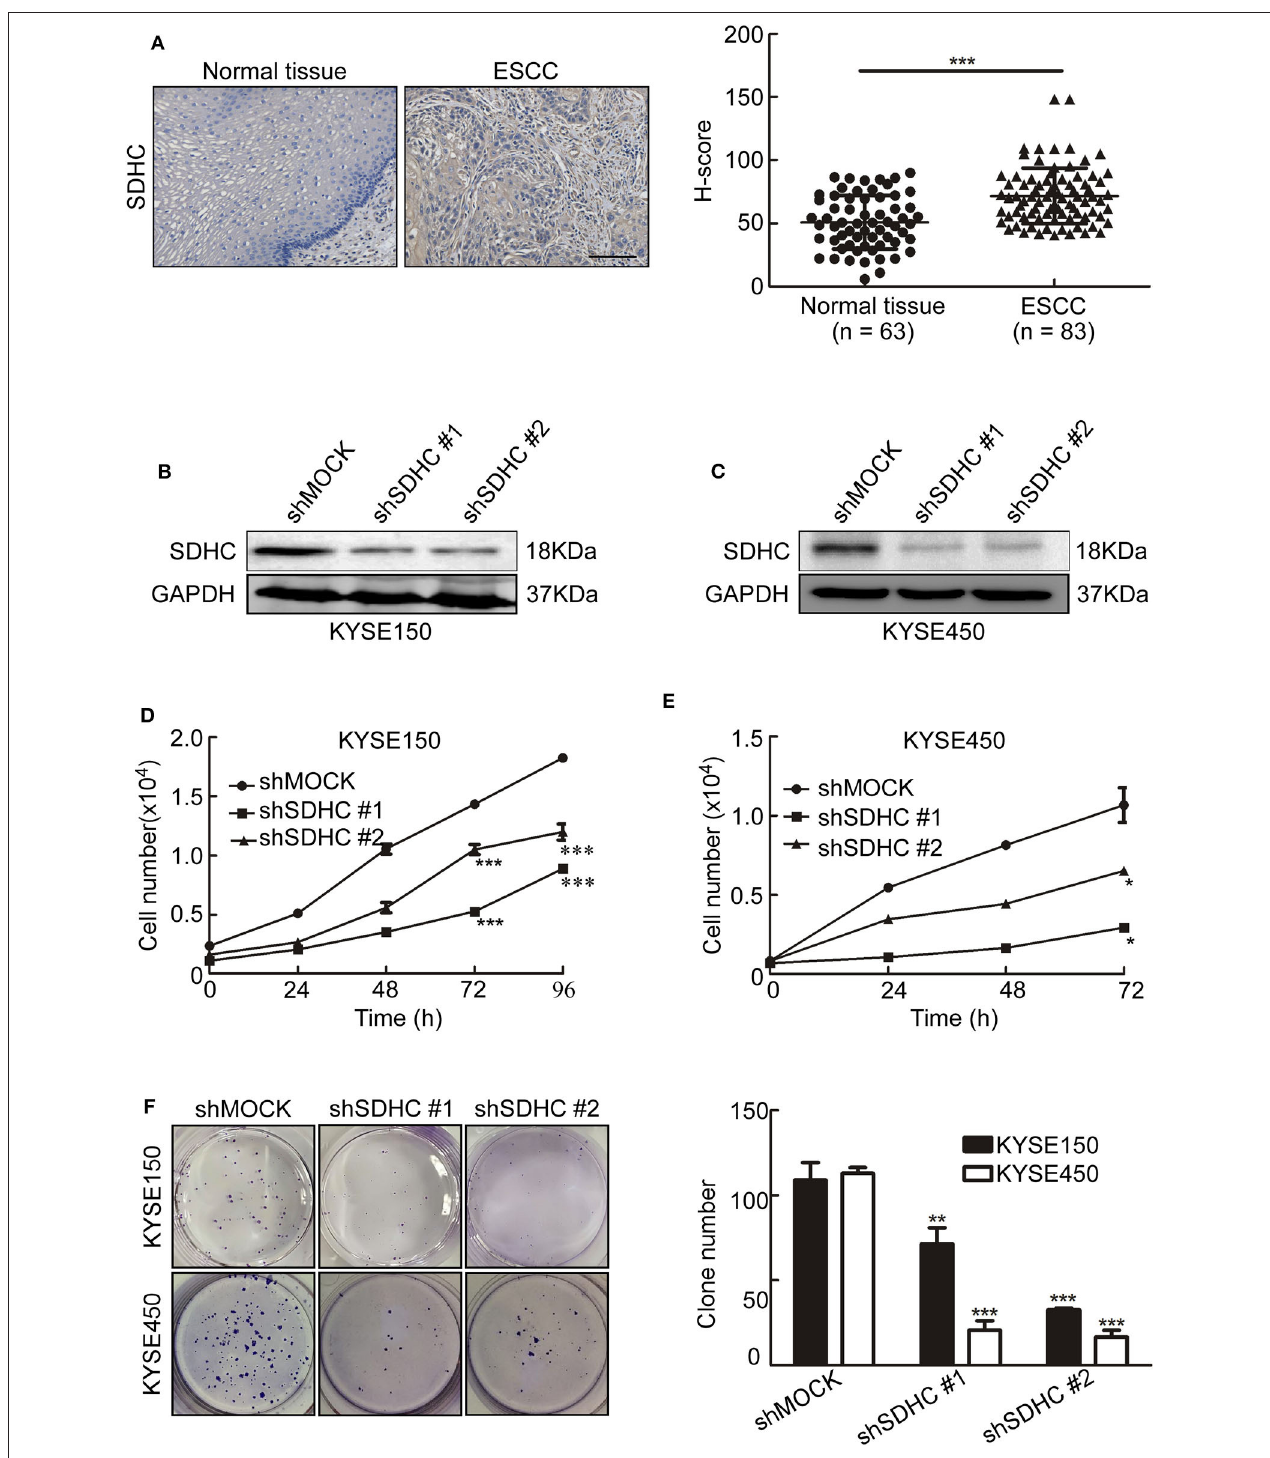
FIGURE 5 | SDHC is highly expressed in ESCC tissues and knocking SDHC down suppresses proliferation of ESCC cells. (A) ESCC tissue spots were incubated with SDHC antibody, then stained with DAB and DAB density was analyzed for ESCC and normal tissues. The asterisks (***) indicate a significant change ( p < 0.001); (B) Short hairpin RNA (sh SDHC ) in vector plko.1 was used to transduce KYSE150 and KYSE450 cells, with knock-down efficiency tested by Western blot in KYSE150 and (C) KYSE450 cells; (D) Cell count for KYSE150 and (E) KYSE450 cells at 0, 24, 48, 72, and 96h; (F) Colony formation for KYSE150 and KYSE450 cells after 10 days. All data are shown as means ± S.D. The asterisks (*, **, ***) indicate a significant decrease ( p < 0.05, p < 0.01, p < 0.001, respectively).